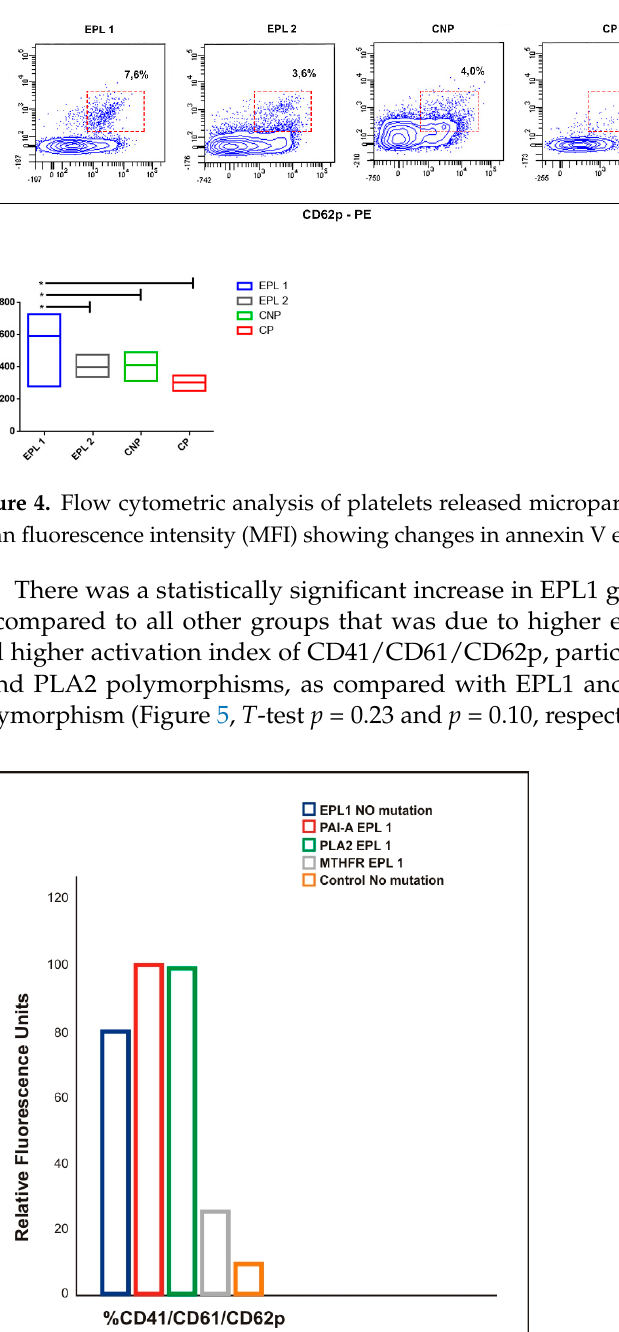
Figure 5. Flow cytometric analysis of platelet activation presented as MFI CD41/CD61/CD62p of the EPL1 group with respect to the carried polymorphisms compared to the control group (T-test p ≤ 0.05).